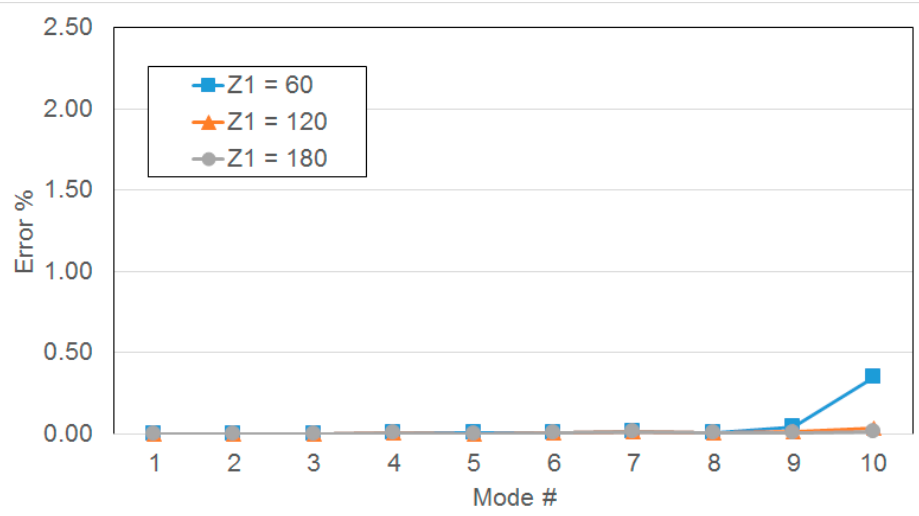
Figure 7. Test Case A (linear elements, Z 2 = 60, h = 1)—accuracy of the two-step method.